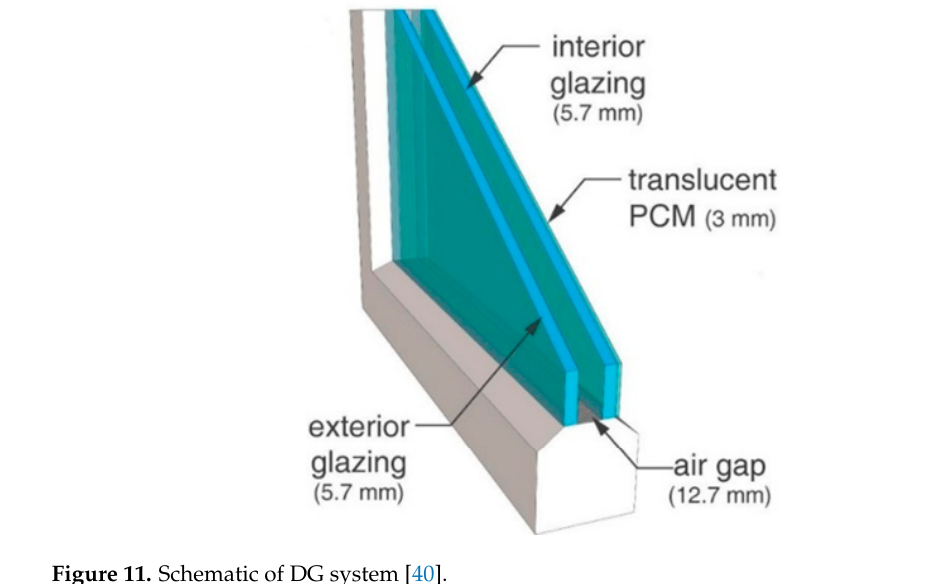
Figure 10. Schematic of fenestration system [39].